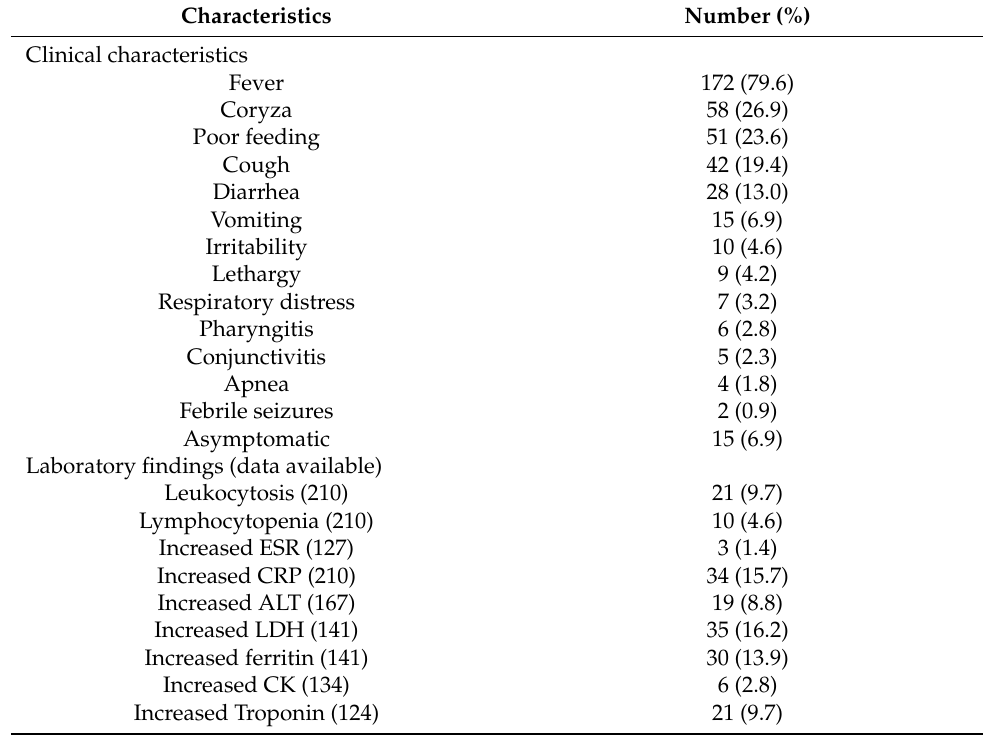
Table 3. Clinical